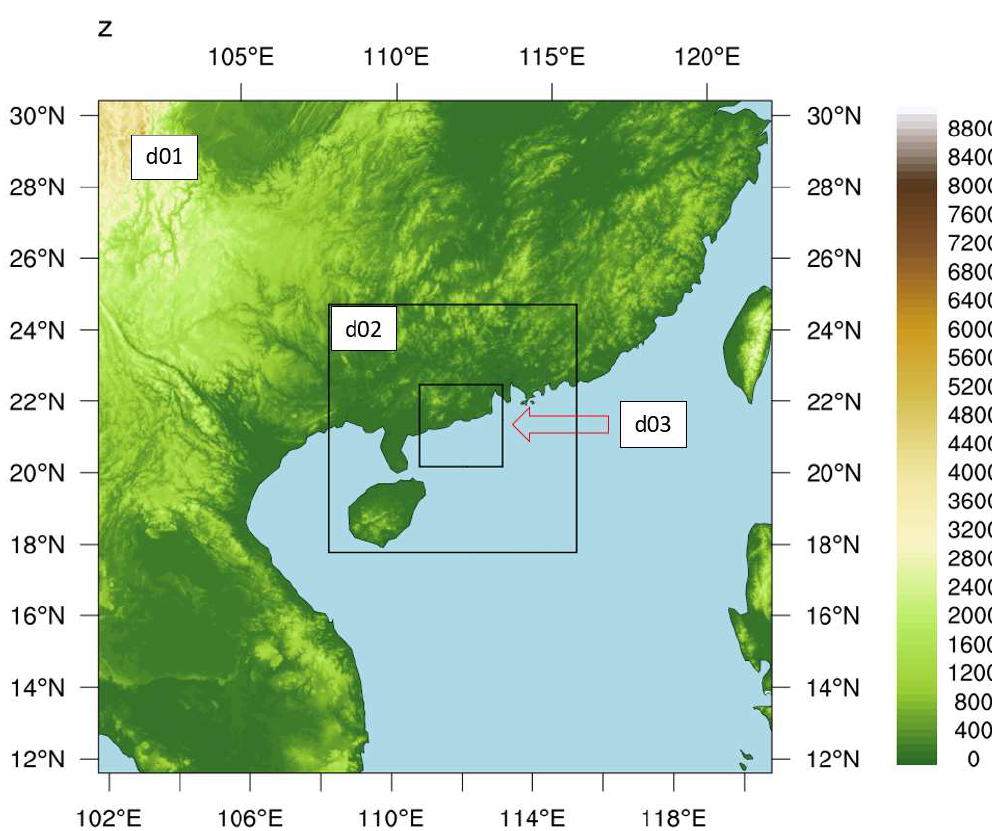
Figure 2. Terrain height of the model’s simulation domains. There are three nested domains: domain 01 (d01), domain 02 (d02), and domain 03 (d03). Table 5. Domain configuration and parameter settings of the Weather Research and Forecast (WRF) model.